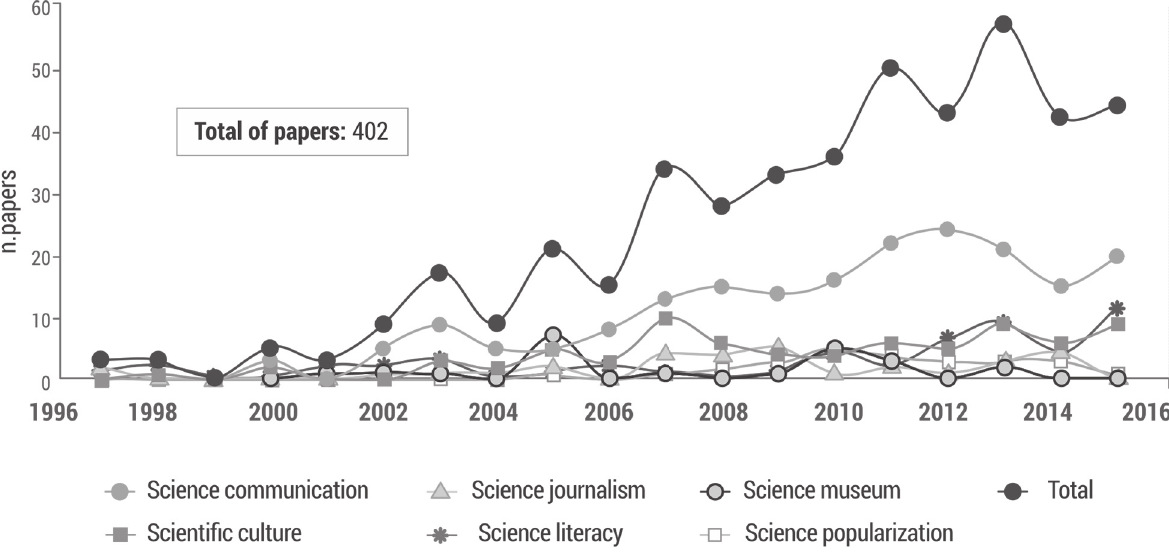
Figure 2 - Distribution of papers published in the SciELO database using 6 keywords related to science communication (1997- 2015). Based on data collected from SciELO in February